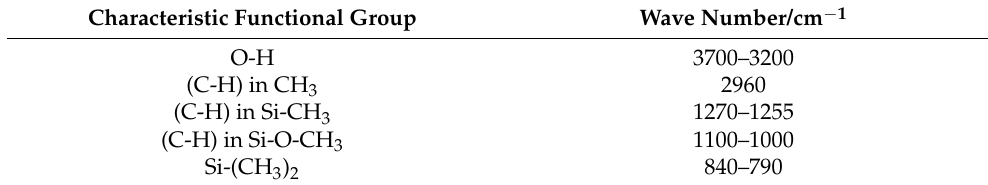
Table 5. The infrared absorption peaks of the main characteristic functional groups of the silicone rubber